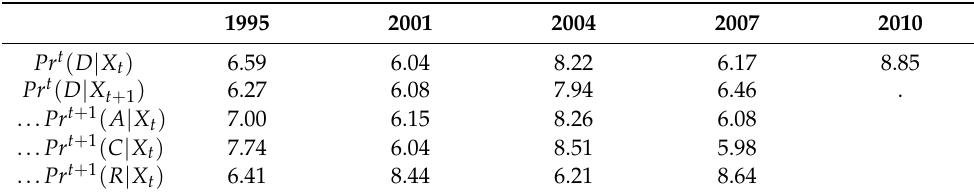
Table 4. Decomposing the Change in Arrears: Parametric